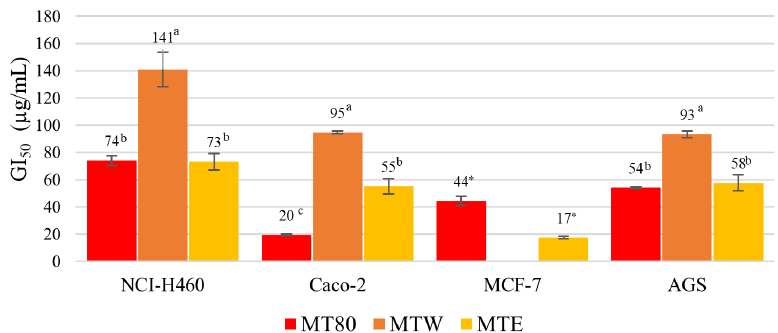
Figure 3. Antiproliferative potential of the mangosteen pericarp extracts. Significant differences between samples are indicated by different letters (Tukey HSD test, p < 0.05) or an asterisk (*) (Student’s t -test, p < 0.05) on the top of the bars.